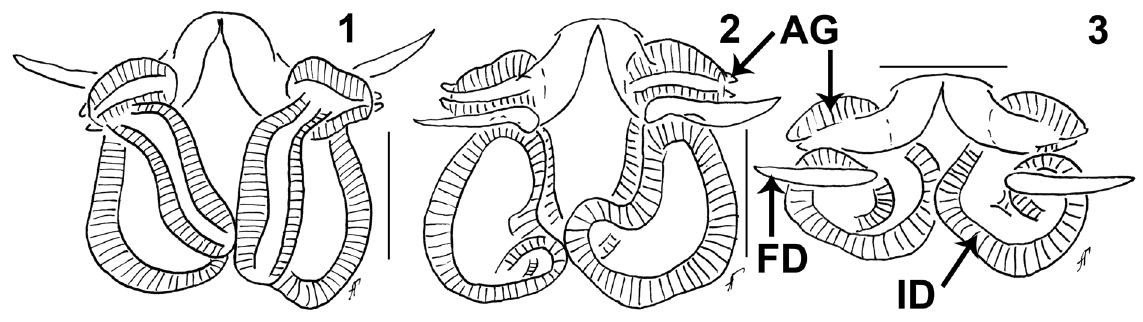
Figs 1–3. Aelurillus v-insignitus (Clerck, 1757). 1–3 . Spermathecae. 1 . Ventral view. 2 . Dorsal view. 3 . Apical view. Scale bars: 0.1